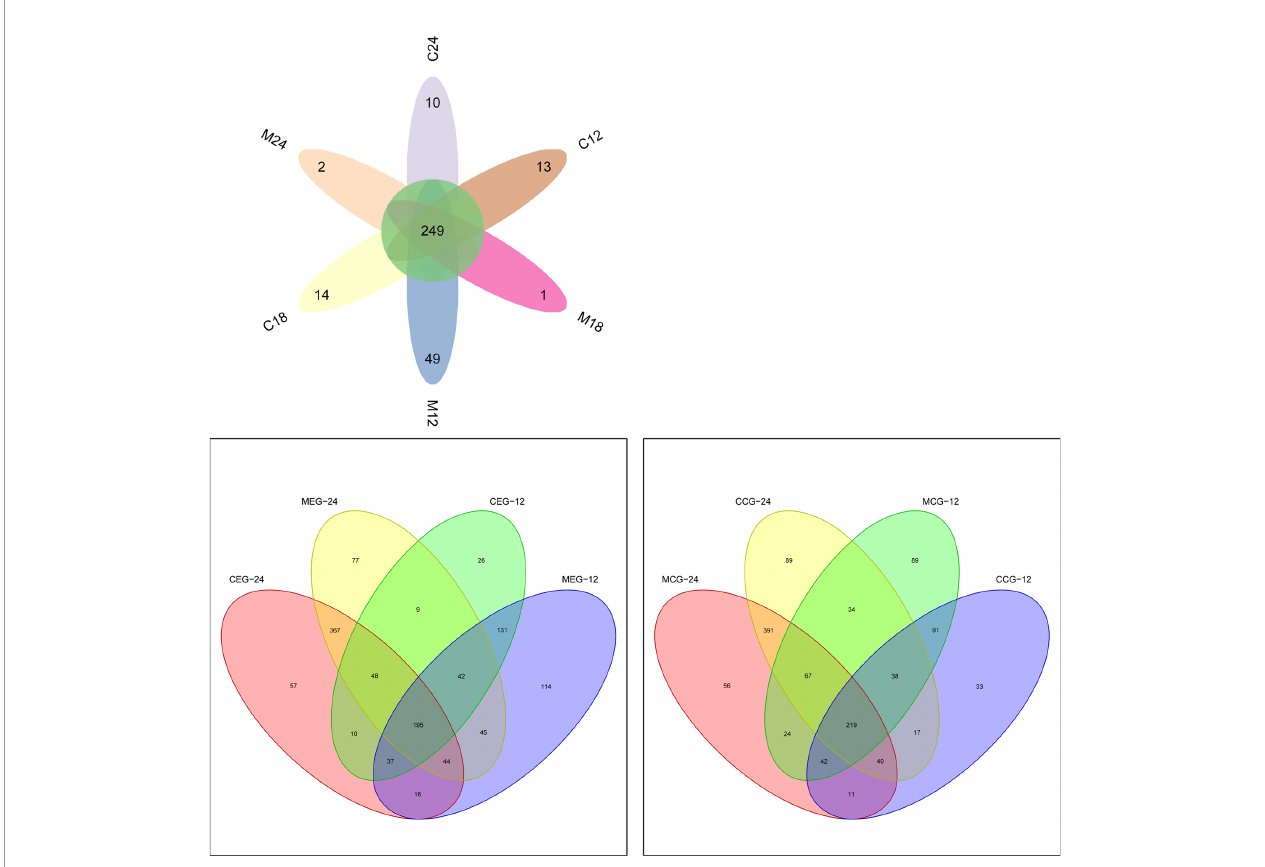
FIGURE 1 | Venn diagram showing shared and unique OTUs at 97% identity between the mother and child